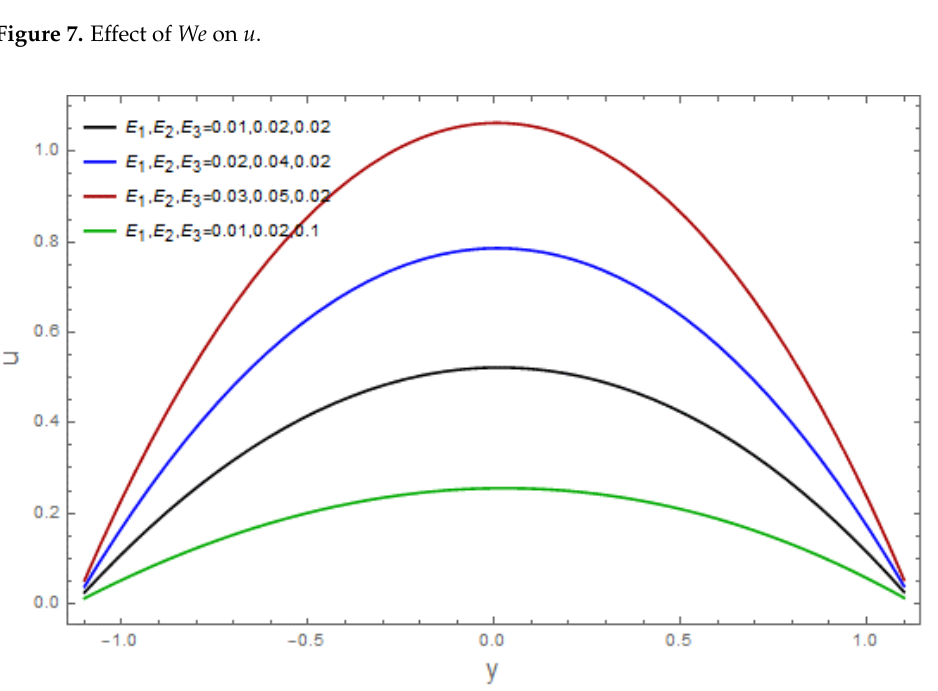
Figure 8. Effects of 𝐸 1 , 𝐸 2 and 𝐸 3 on 𝑢 .